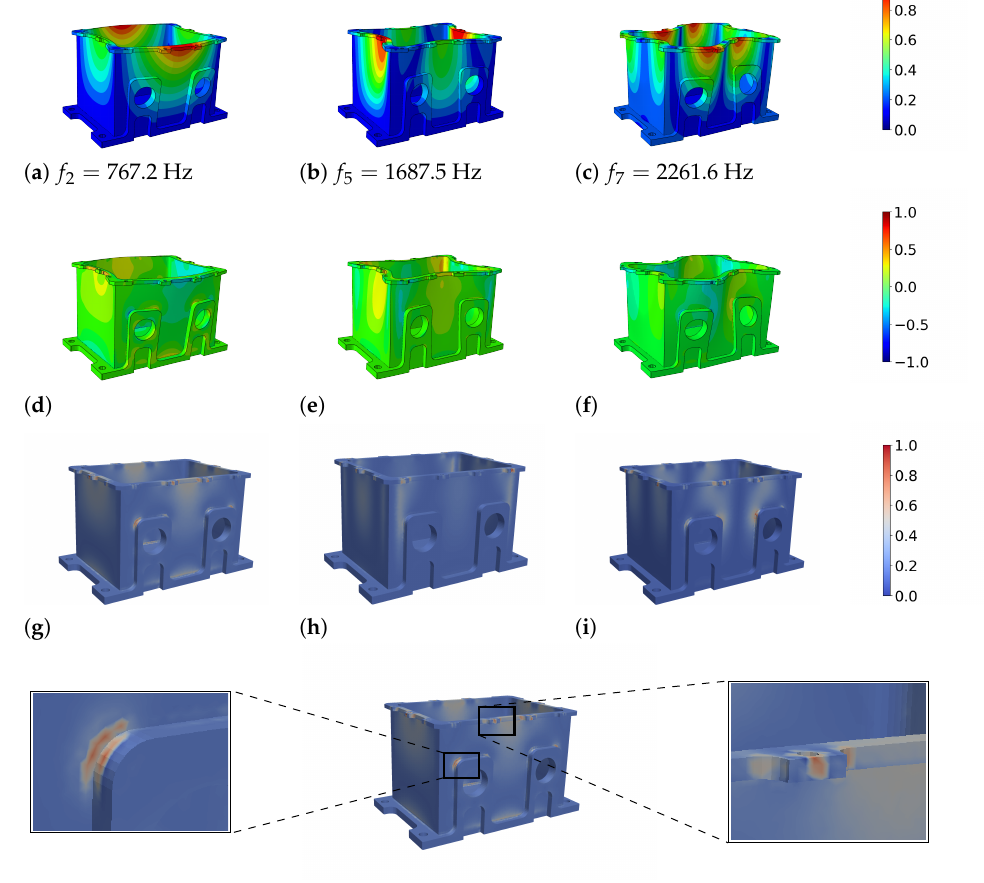
Figure 7. ( a – c ) Mode shapes 2, 5 and 7 of the box component; displacement magnitude normalized to 1. ( d – f ) Distribution of hydrostatic pressure σ kk = σ xx + σ yy + σ zz . ( g – i ) Spatial distribution of the dissipated energy, Q , at time T /4. The values were normalized to 1 with respect to the maximum in each mode since they were based on relative displacements and temperature fields. ( j ) Detailed view of locations with high energy